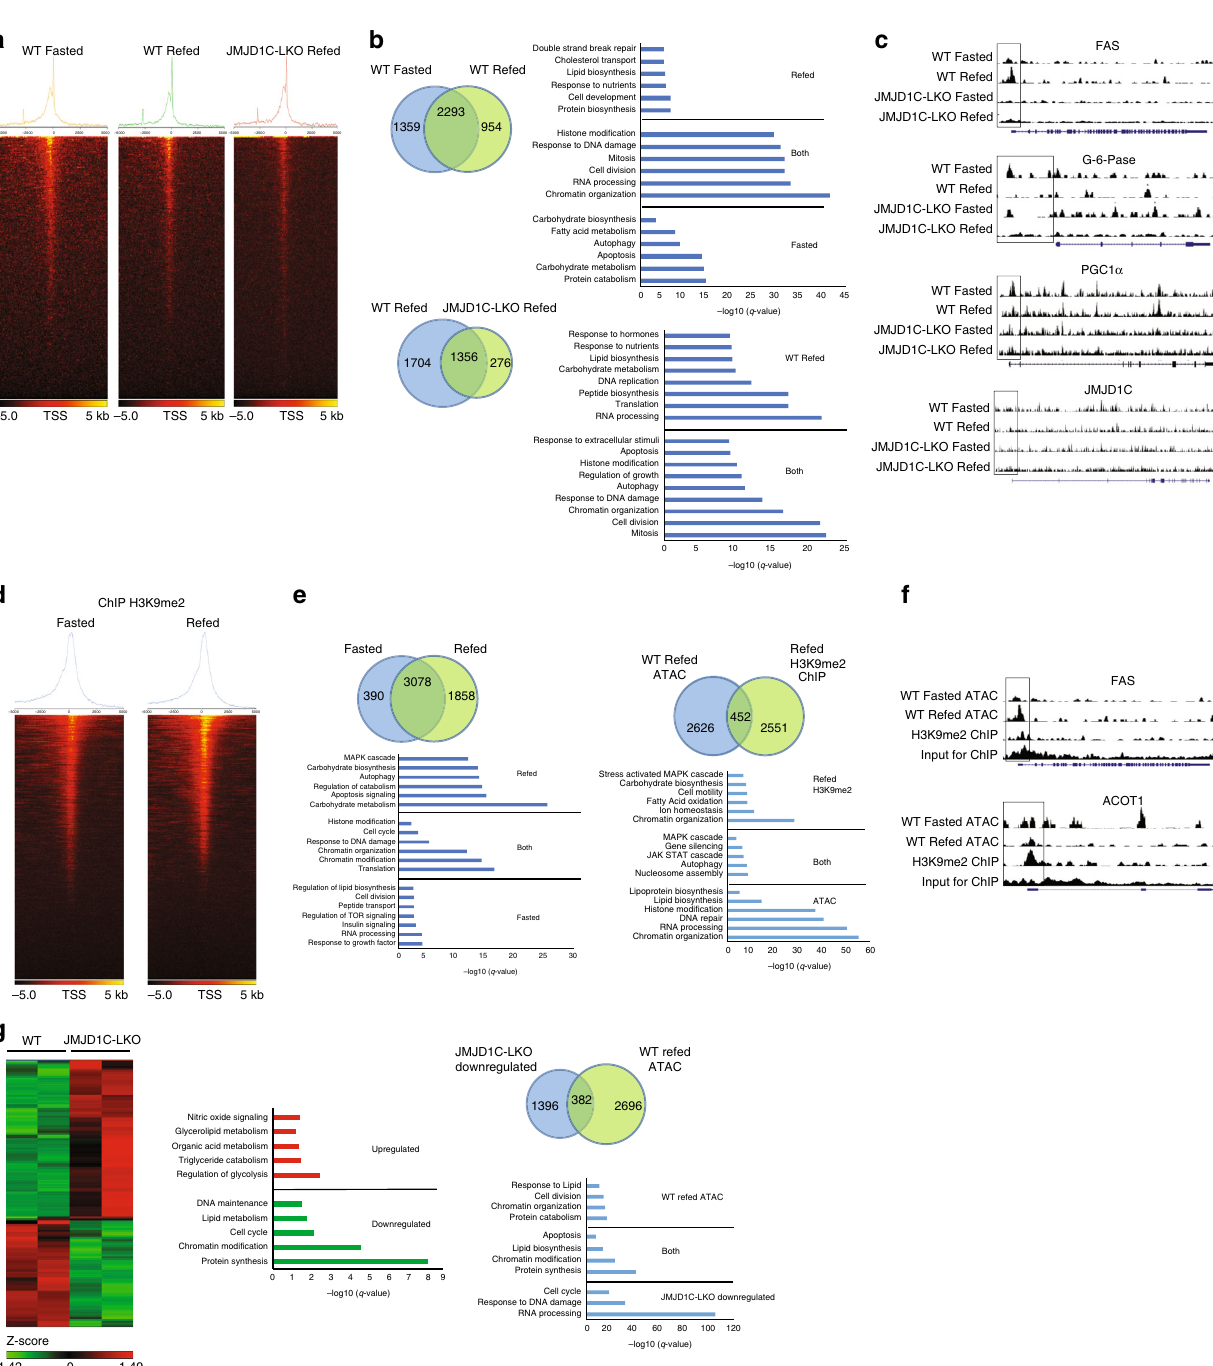
Fig. 5 Genome-wide analyses of JMJD1C function in liver. a – c ATAC-seq using livers from WT and JMJD1C-LKO mice that were fasted or refed. n = 2 per group. a Heatmaps showing open chromatin regions focused at the transcription start site (TSS). Color scale shows peaks detected, black is equivalent to zero, yellow is equivalent to 500. b Venn diagrams showing number of unique or shared genes and charts for representative top gene ontology (GO) terms. c UCSC genome browser screenshot of representative peaks at a subset of promoter regions. d – f H3K9me2 ChIP-seq using livers from WT refed mice, n = 2 per group. d Heatmap showing H3K9me2 enrichment at TSS (color scale shows peaks detected, black is equivalent to zero, yellow is equivalent to 500) and e representative top GO terms for genes detected to be H3K9me2 enriched differentially upon fasting or refeeding. Venn diagrams showing number of unique or shared genes between ATAC- and ChIP-seq datasets and charts for representative top gene ontology (GO) terms (right). f UCSC genome browser screenshot of representative peaks at a subset of promoter regions. g RNA-seq using livers from refed WT and JMJD1C-LKO mice, n = 2 pooled RNA samples per group. Heatmap showing changes in gene expression between WT and JMJD1C-LKO mice (left), Color scale shows changes in gene expression as determined by Z -score, green is – 1.42 and red is 1.49. Representative top GO terms of upregulated and downregulated genes identi fi ed by differential expression analysis (middle). Venn diagrams showing number of unique or shared genes between ATAC- and RNA-seq datasets and charts for representative top gene ontology (GO) terms